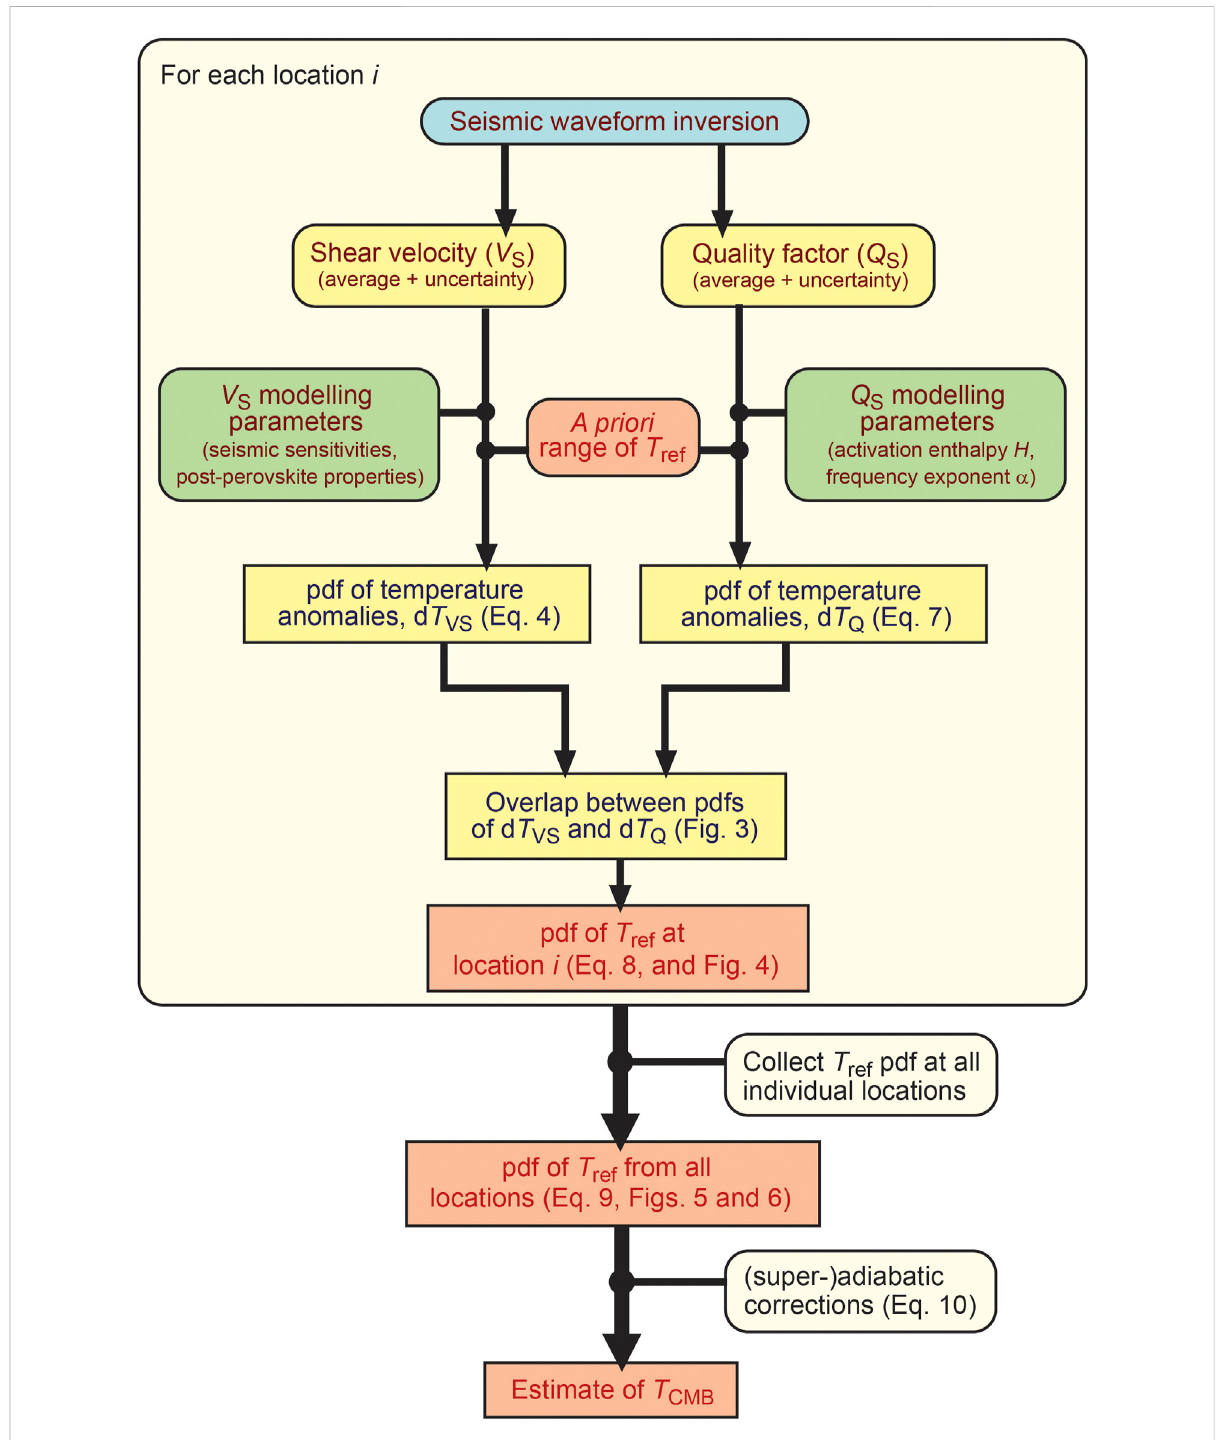
Flow chart of the method used to evaluate the temperature at the CMB, T CMB , from observed shear velocity ( V S ) and seismic quality factor ( Q S ) measurements atdifferent locations i . For each location, we fi rst calculate a probability density function (pdf) ofthe average temperature inthe layer above the CMB, T ref , by comparing the pdfs of temperature anomalies predicted by the deviations of V S and Q S from PREM. We then combine the local pdfs of T ref to calculate a total pdf of T ref . Finally, because T ref is sampling a layer whose thickness is fi xed by the resolution of seismic models, we make a correction for adiabatic and super-adiabatic temperature increase throughout this